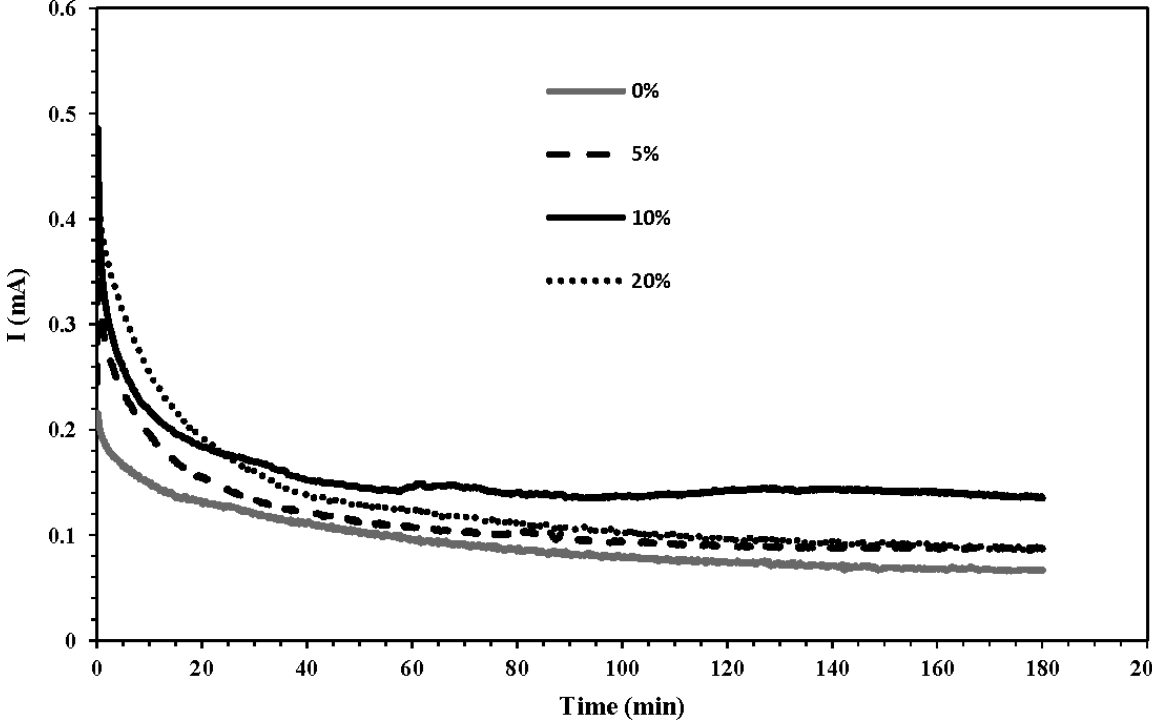
Figure 7: Chronoamperometry curves for steel electrode in the brine solution in the absence and the presence of different concentrations of Gypsophila aretioides extract at